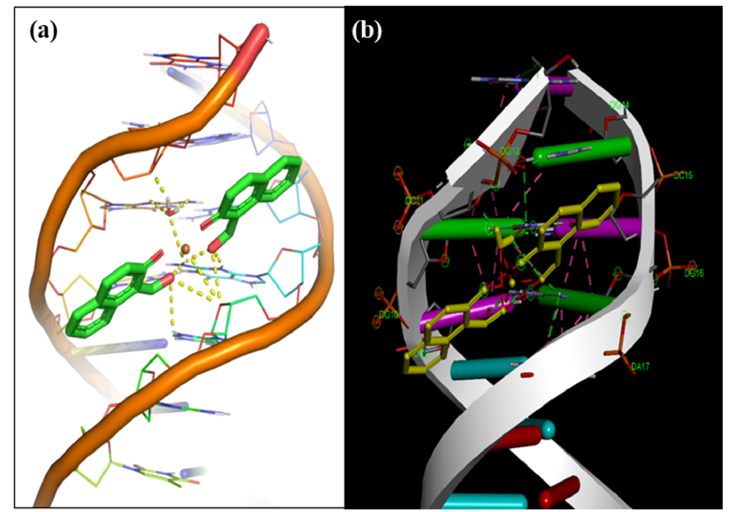
Figure 11. Docked pose for complex 1 with DNA (1BNA).